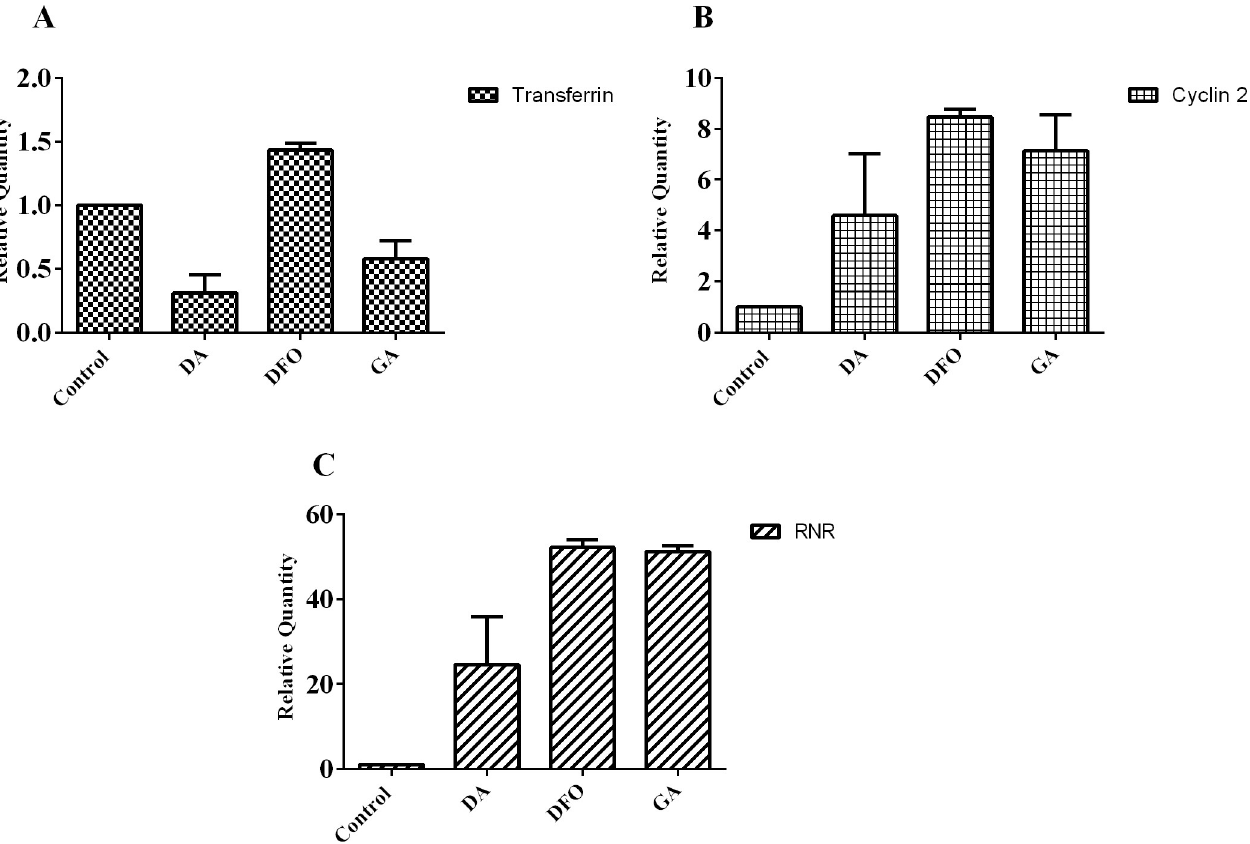
Fig 7. Relative gene expression of iron dependent genes. RT-qPCR analysis of mRNA expression of (A) Transferrin receptor (B) Cyclin 2 (C) Ribonucleotide reductase after treatment with diminazene aceturate (DA), deferoxamine (DFO) and gallic acid (GA) for 24 hours. The values are expressed as the relative quantity with respect to the control. The data represent the average of two independent